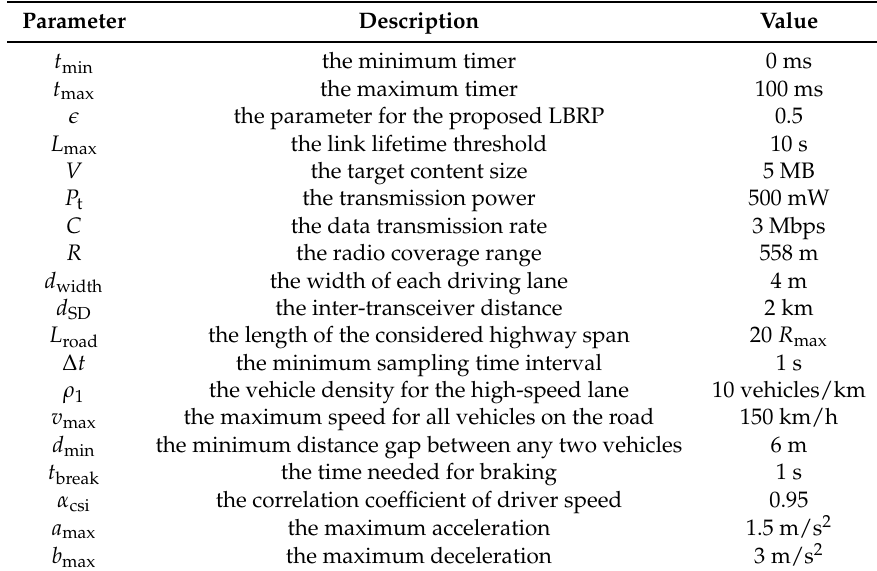
Table 2. The default values of the main parameters in our simulations. LBRP, Lifetime-aware Beacon-less Routing